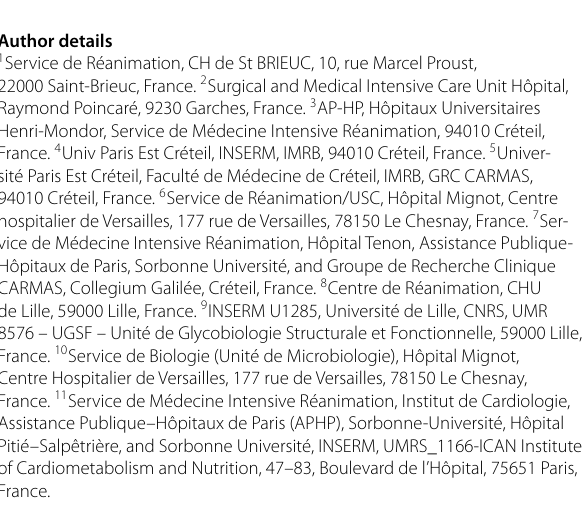
Patients with BSI